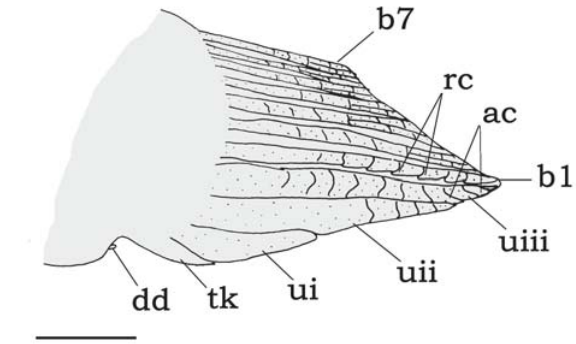
Fig. 12. Male modified anal fin of Tatia boemia , MCP 12949, paratype, 59.9 mm SL. Left side lateral view. Abbreviations: ac, antrorsely curved denticulation; b1, branched first ray; b7 , branched seventh ray; dd , deferent duct; rc , retrorsely curved denticulation; tk , tegumentary keel; ui , unbranched first ray; uii , unbranched second ray; uiii , unbranched third ray. Scale bar = 1.0